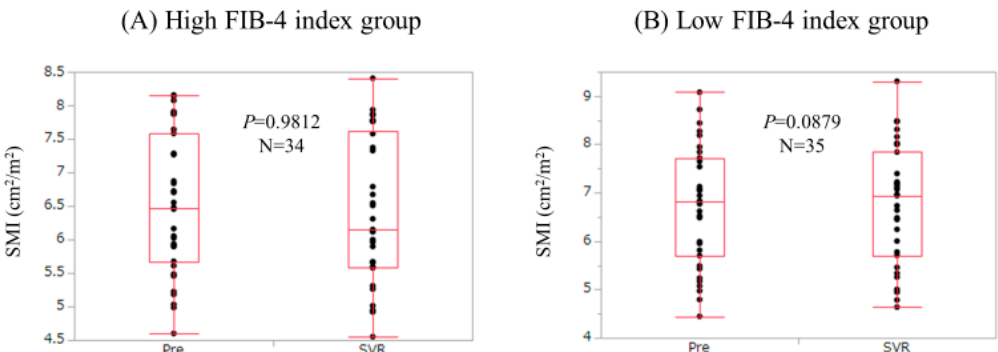
Figure 2. Changes in SMI according to baseline FIB-4 index. ( A ) Patients with baseline FIB-4 index ≥ 2.46 (the median value in our cohort) were defined as the high FIB-4 index group ( n = 34). SMI at SVR did not significantly increase as compared with baseline levels ( p = 0.9812); ( B ) Patients with baseline FIB-4 index <2.46 were defined as the low FIB-4 index group ( n = 35). SMI at SVR tended to significantly increase as compared with baseline levels ( p = 0.0879).